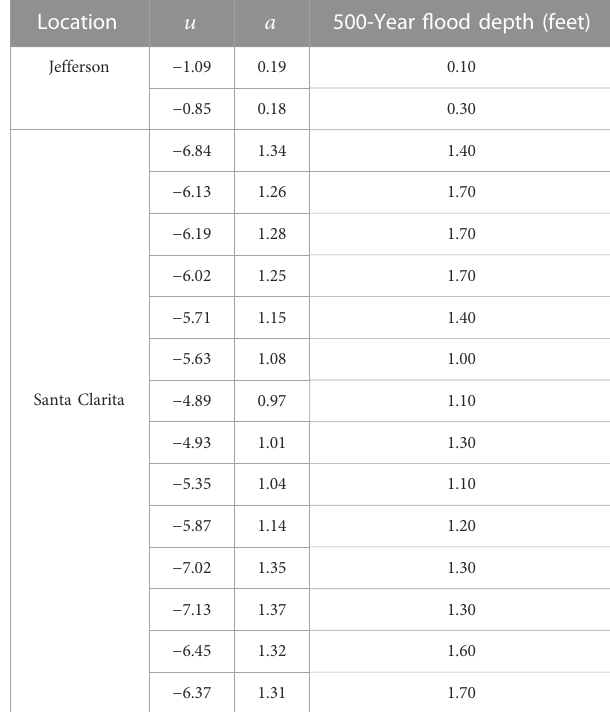
TABLE 9 Flood parameters and 500-year fl ood depth for the shaded X Zone located in Jefferson Parish, Louisiana, and Santa Clarita, California, using spatial